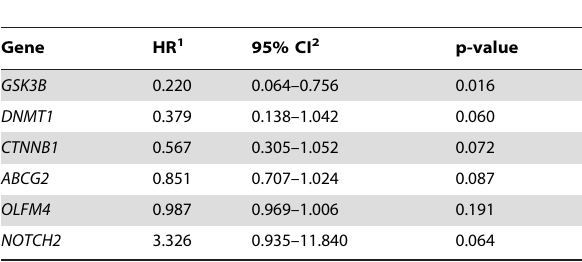
Table 4. Gene expression and association with survival – univariate Cox regression analysis.